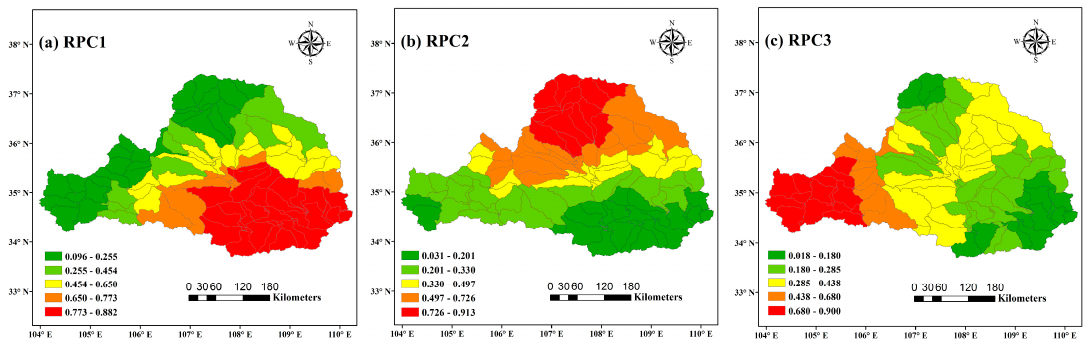
Figure 10. Spatial patterns of the rotated loadings of the first three principal components based on principal component analysis on the PDSI_SWAT time series: ( a ) RPC1, ( b ) RPC2 and ( c ) RPC3.